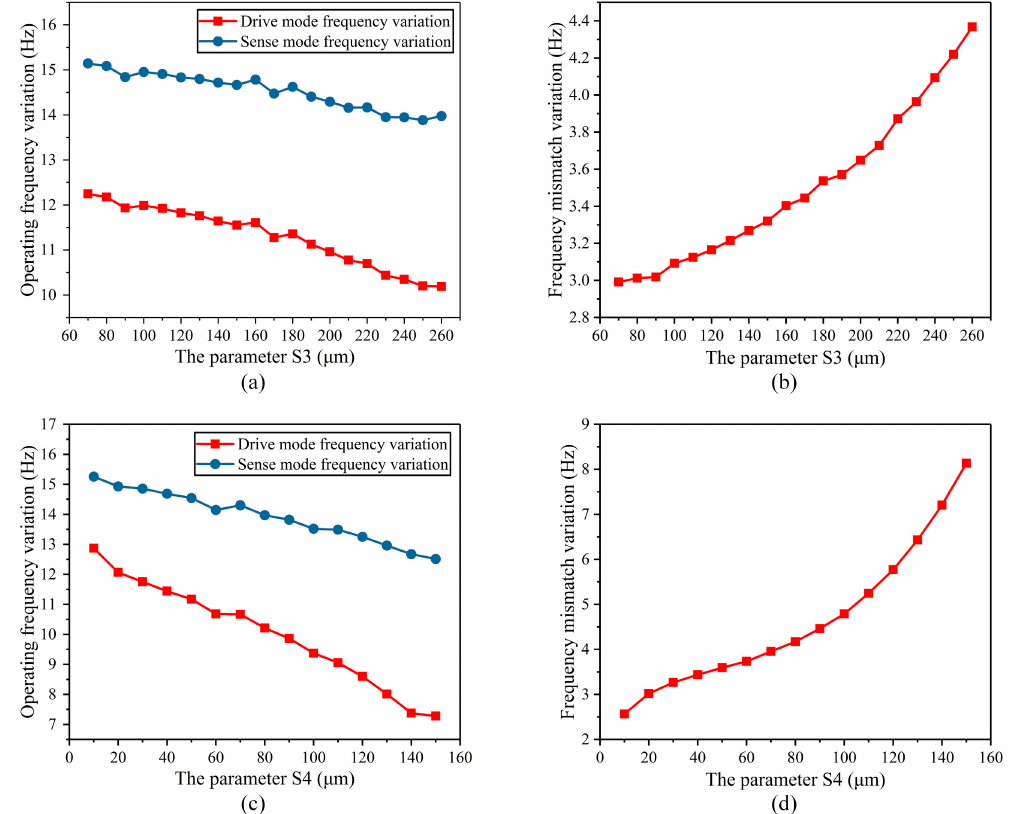
Figure 8. The parameter of the height of the internal fixed frame of the stress-released structure (S 3 ) and the height of the outer fixed frame of the stress-released structure (S 4 ) affected the variation of the operating frequency and frequency mismatch: ( a ) The degree of variation of the operating frequency of the parameter of S 3 ; ( b ) the degree of variation of the frequency mismatch of the parameter of S 3 ; ( c ) the degree of variation of the operating frequency of the parameter of S 4 ; ( d ) the degree of variation of the frequency mismatch of the parameter of S 4 .